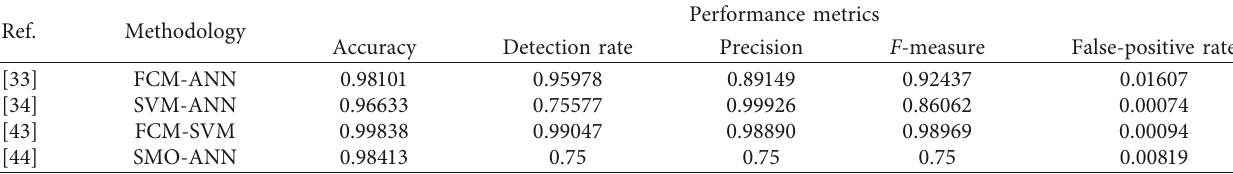
Table 8: Comparison of various methodologies based on different performance metrics for Fuzzer attack. Ref.